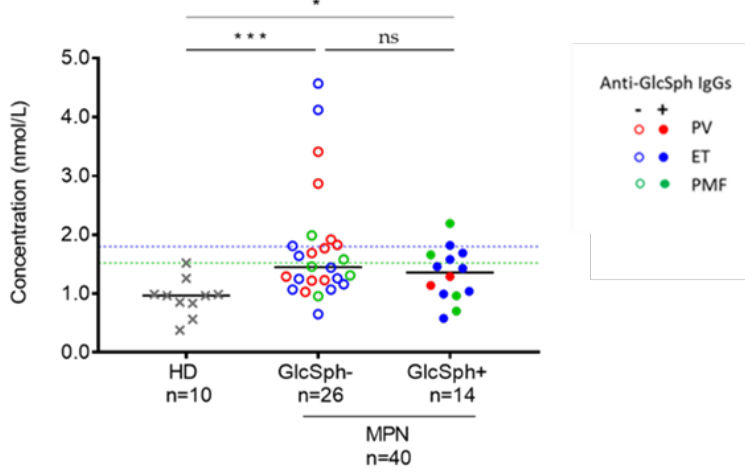
Figure 7. GlcSph levels measured in the blood serum of MPN patients. GlcSph − : MPN patients without GlcSph-reactive IgGs; GlcSph + : MPN patients with GlcSph-reactive IgGs. (*) p < 0.05, (***) p < 0.001, Mann–Whitney t -test. Median values are represented by black bars. The dotted blue line represents the upper normal value for healthy individuals (1.8 nmol / L). The dotted green line represents the upper value of our control cohort of HDs.